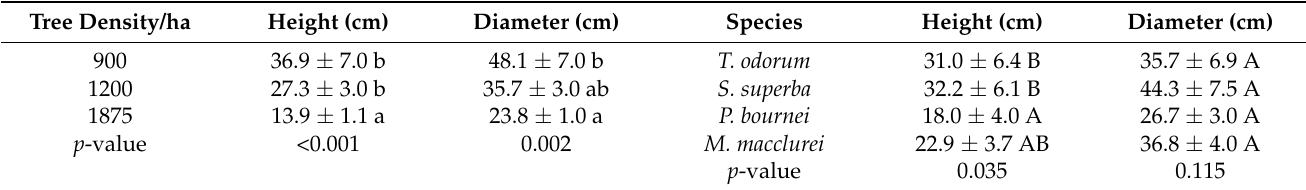
Table 2. Annual growth rate of seedlings of four broad-leaved trees species underplanted in Chinese fir plantations with different tree density levels (Mean ± SE). Means followed by different lower case letters are different among tree density levels and those followed by upper case letters are significantly different among species.